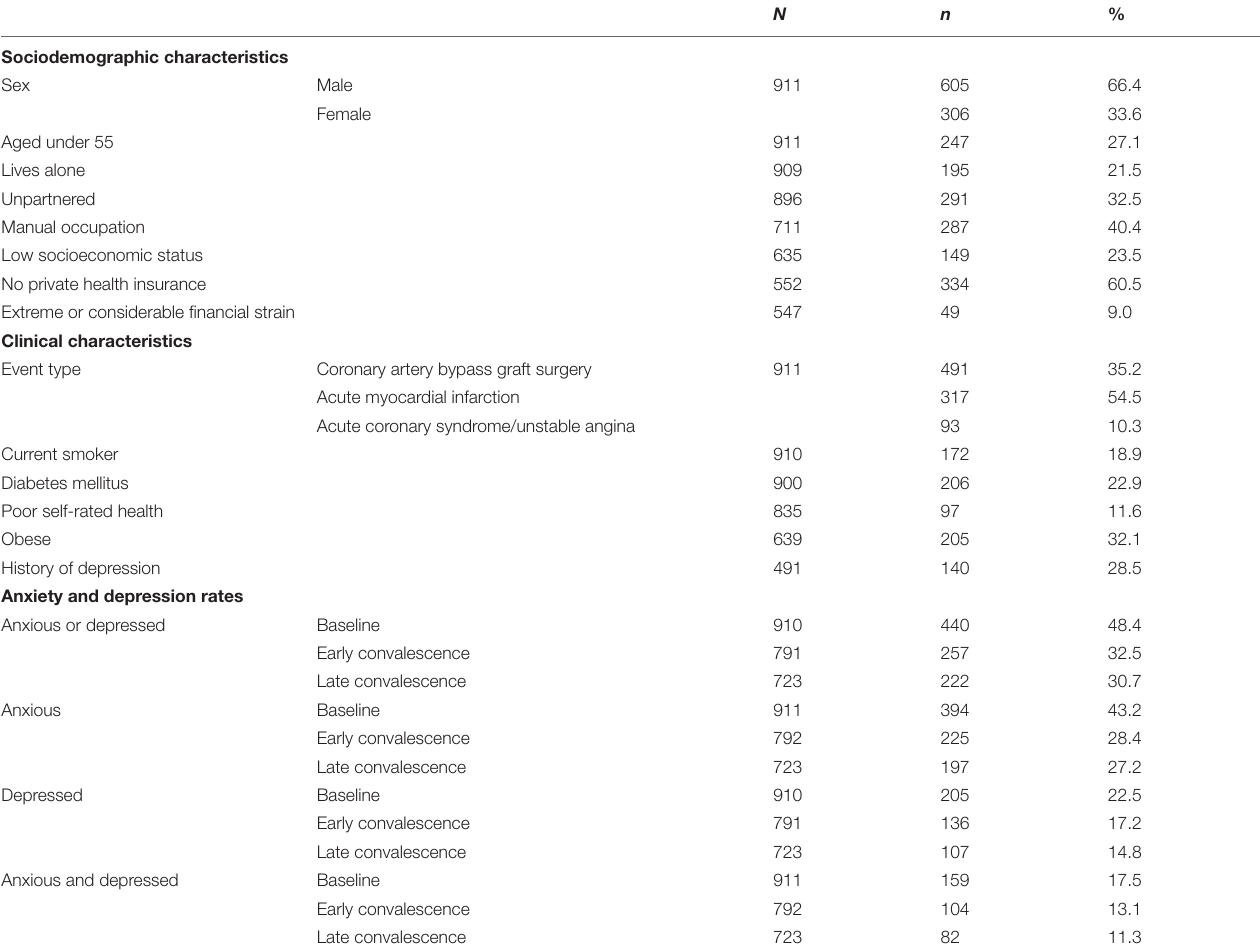
TABLE 1 | Characteristics of the sample.